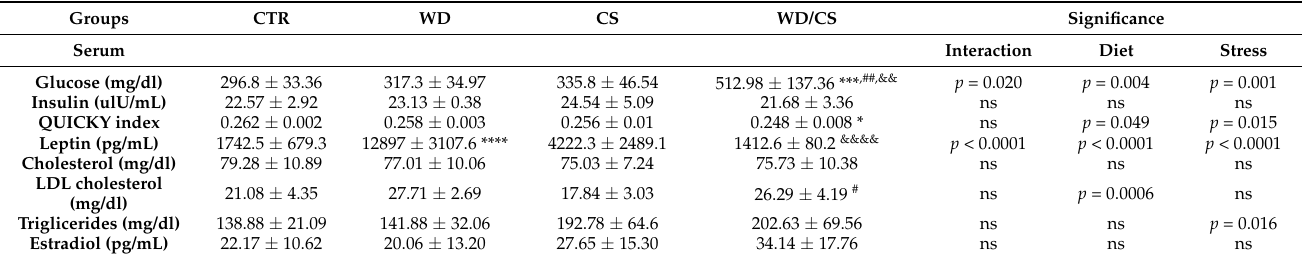
Table 2. Biochemical and hormonal parameters serum of rats subjected to a Western diet and/or chronic